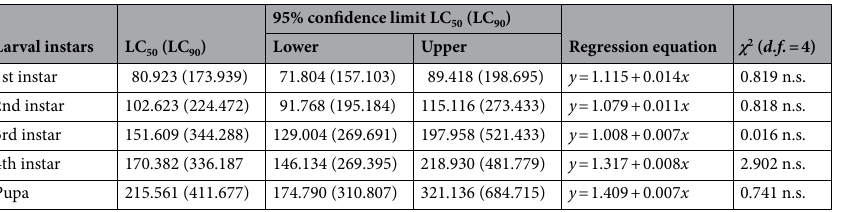
Table 1. Larval and pupal toxicity of sardine fish scales extract against Anopheles stephensi. No mortality was observed in the control. LC 50 : lethal concentration was killing half of the treated organisms, LC 90 : lethal concentration was killing 90% of the treated organisms, χ 2 : Value of the chi-square, d.f. : degree of freedom, n.s.: non-significant (α =